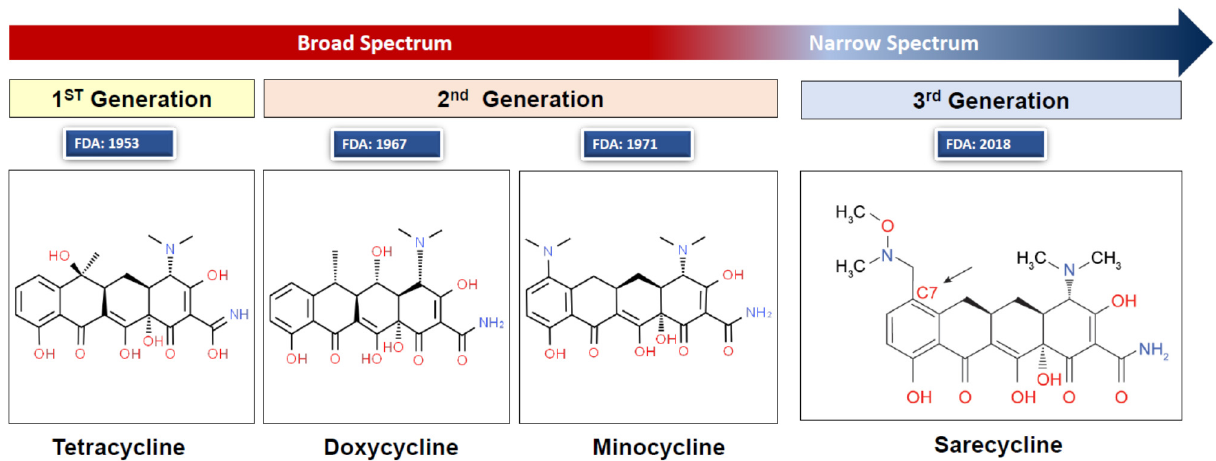
Figure 1. Chemical structures of tetracycline, doxycycline, minocycline, and sarecycline. Structure image source: http://www.chemspider.com/Chemical-Structure.28540486.html (accessed on 10 January 2020). Image created and pro- vided with permission by Almirall LCC, Exton, PA, USA.